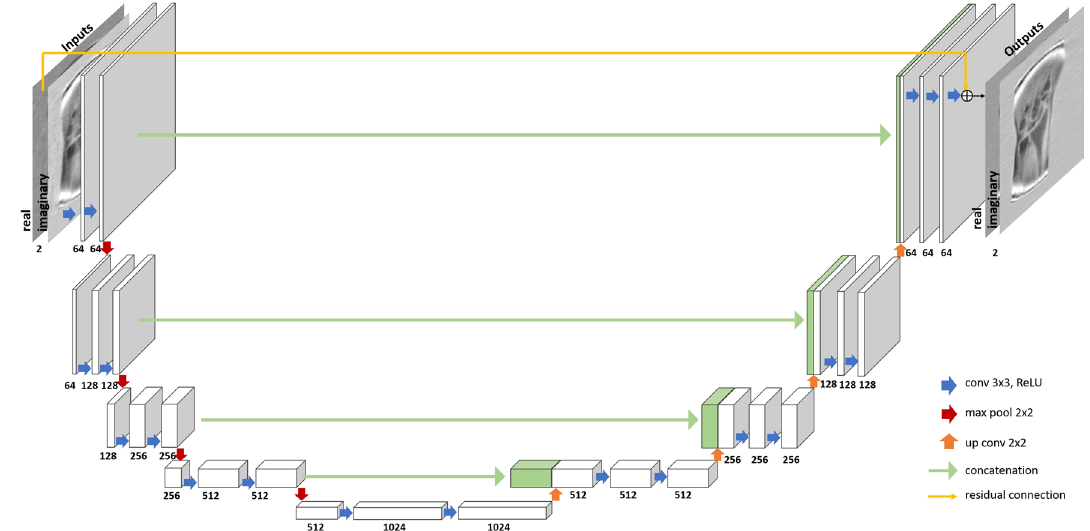
Figure 1. The chosen Residual U-net used to reconstruct LF undersampled